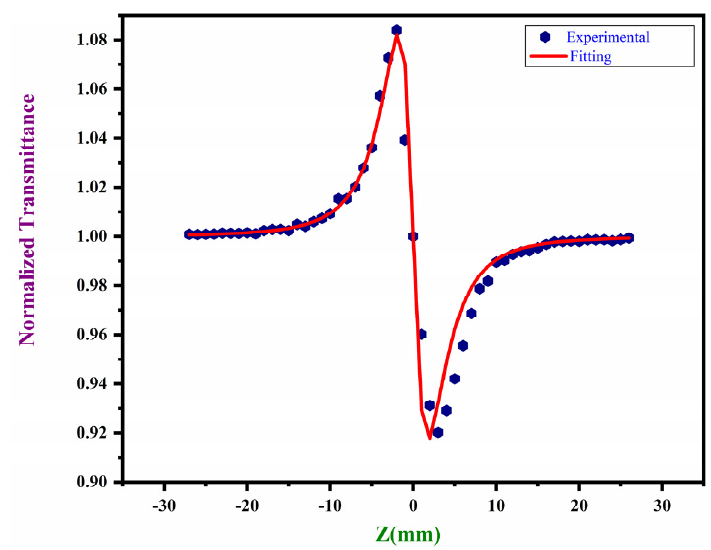
Figure 17. Closed aperture Z-scan trace of Figure 17. closed aperture Z-scan trace of MMPI.